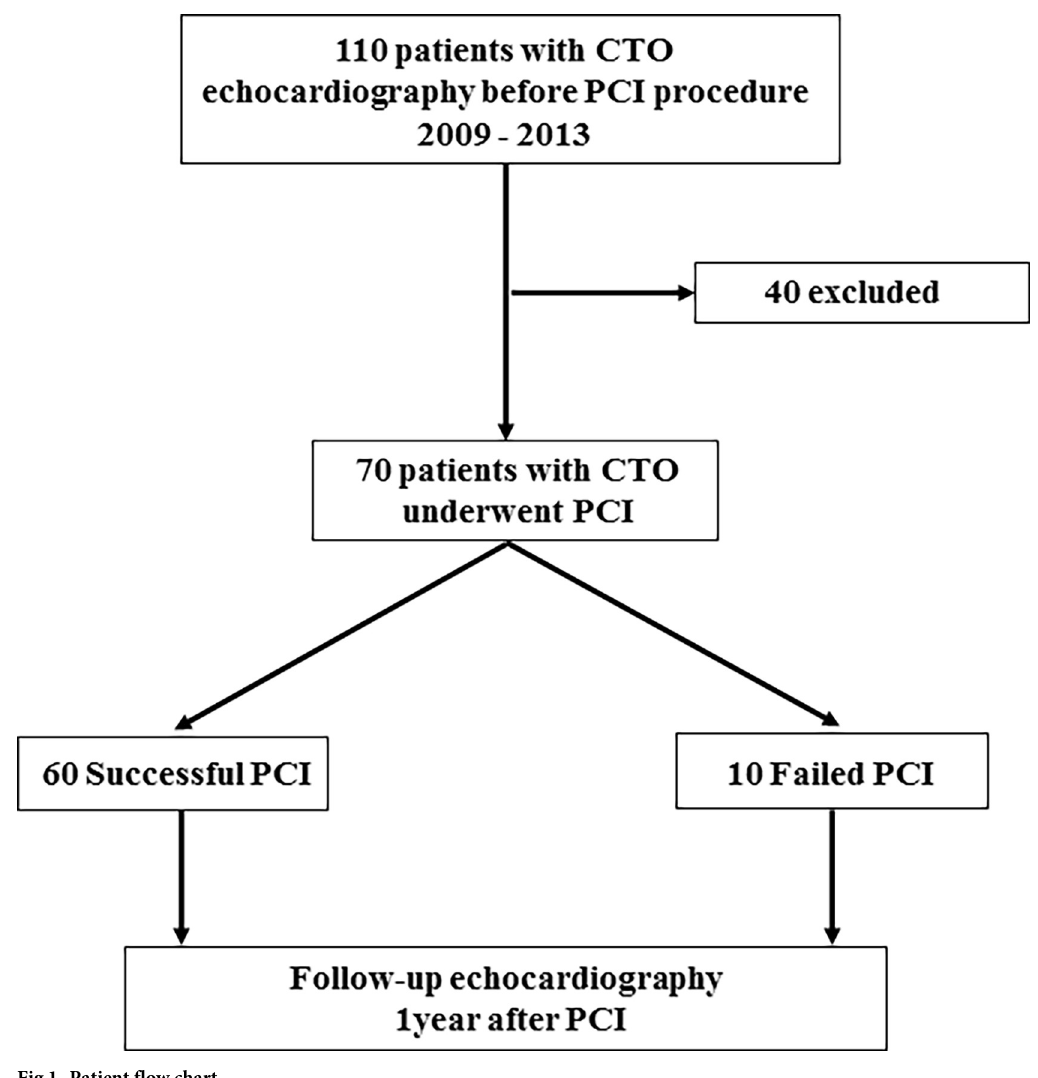
Fig 1. Patient flow chart.